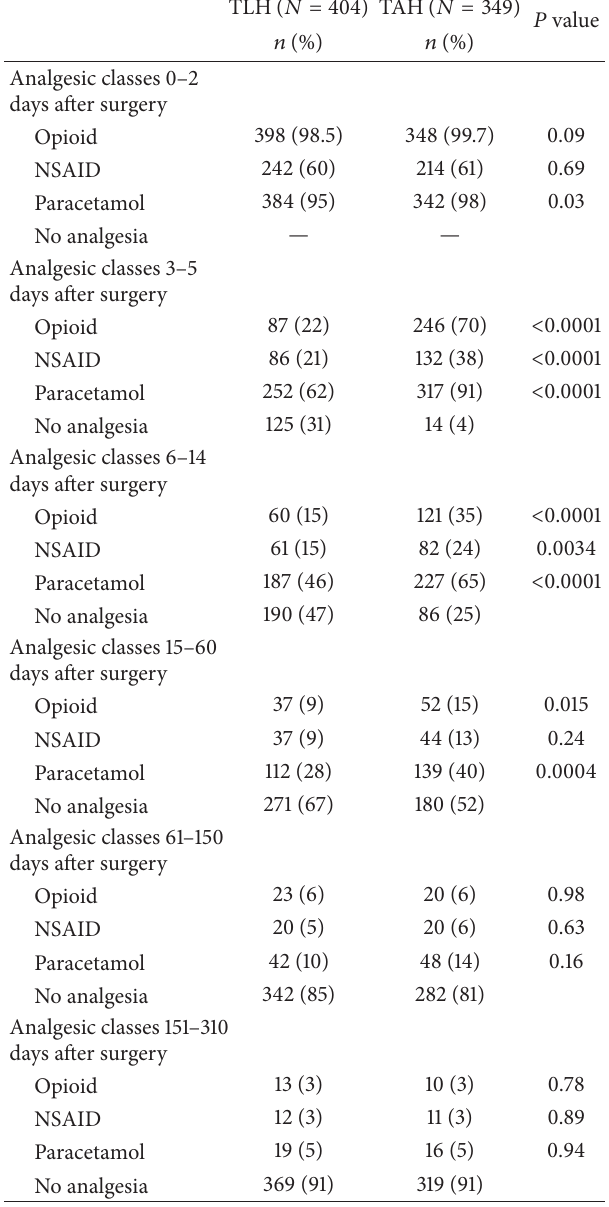
Table3:Postoperativeanalgesicuse,excluding7 ptswithout6-week followup ∗